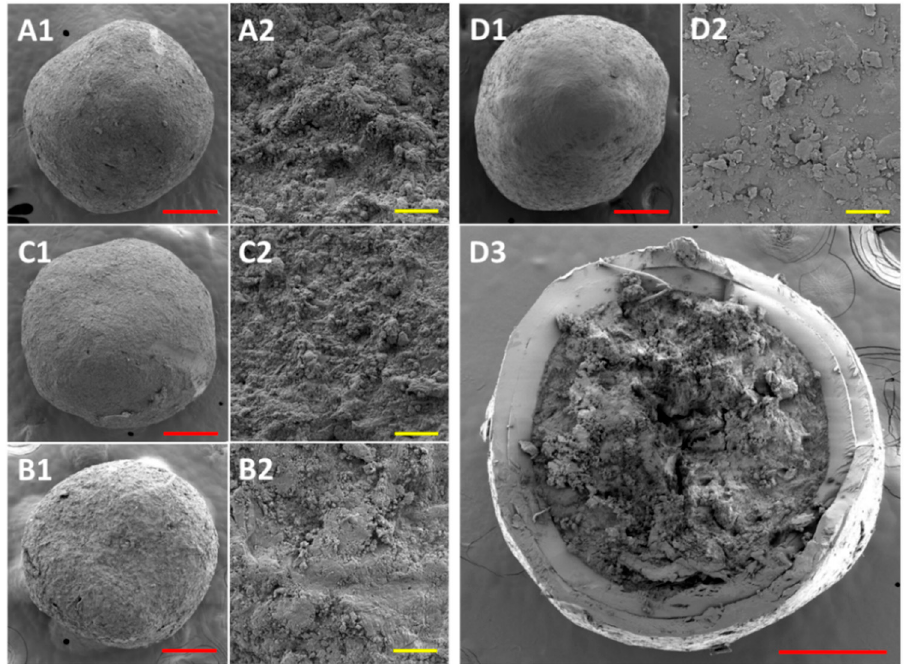
Figure 4. SEM images of selected samples: ( A 1 , A 2 ) sample M1-W90; ( B 1 , B 2 ) sample M2-W90; ( C 1 , C 2 ) sample M3-W90; ( D 1 – D 3 ) sample C-M3-W90. Note: 1 represents the whole pellet, 2 represents the detailed surface, and 3 represents the pellet cross-section. The red and yellow bar corresponds to a length of 200 µm and 10 µm, respectively.